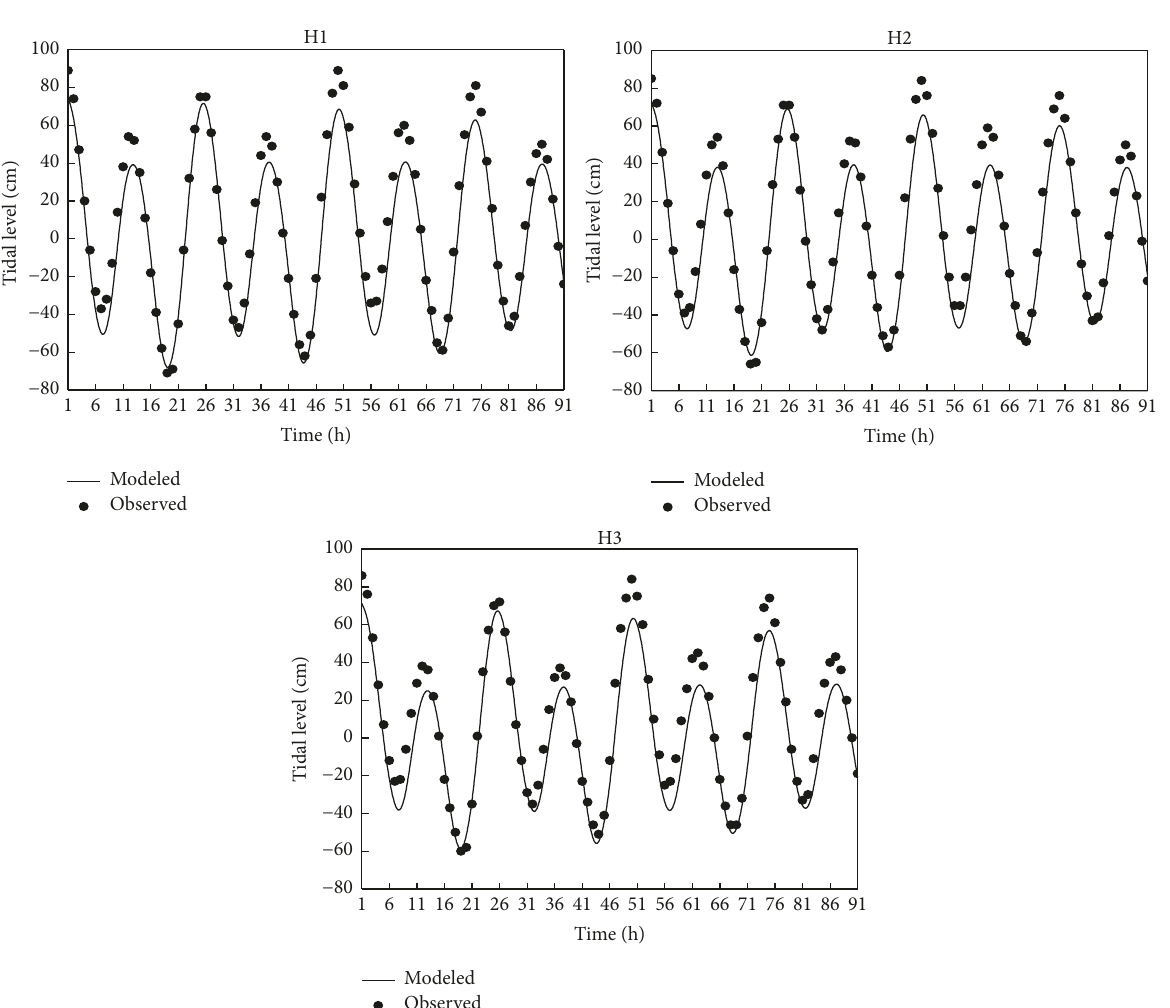
Figure 9: Comparison of the tidal level between the modeled (solid line) and the observed (dots) results at three stations (H1, H2, and